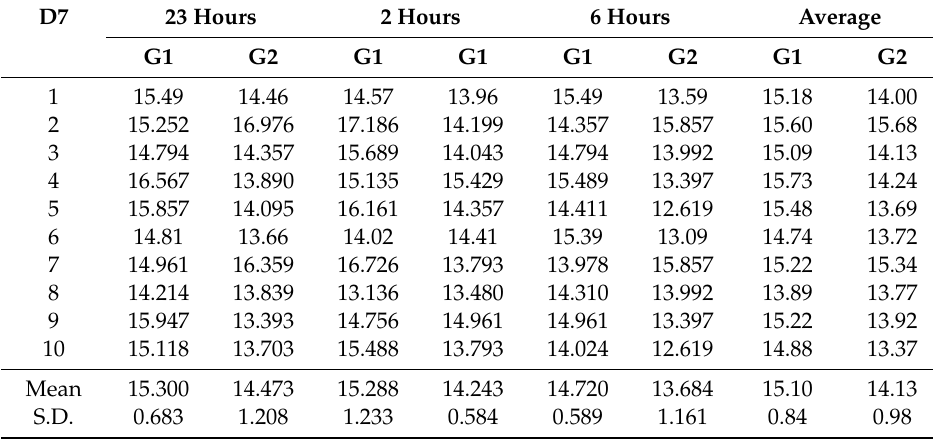
Table 4. Test animal serum 25(OH)D analysis results (D7, unit: ng / mL).